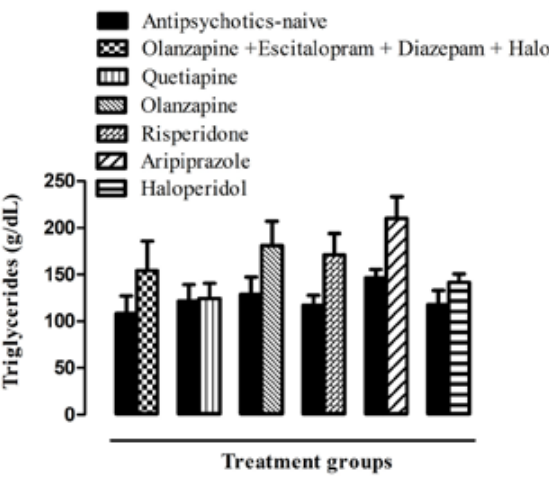
FIGURE 8 - Effect of selected antipsychotics on triglycerides (TGs): Antipsychotic-naïve patients were treated with olanzapine in combination with escitalopram, diazepam (STAT, I.V) and haloperidol (STAT, I.M) (OLEDH, n=8), or quetiapine (QUET, n=8), olanzapine (OLAN, n=8), risperidone (RISP, n=8), aripiprazole (n=8) or haloperidol (n=8) in therapeutic doses for an average time period of 39, 40, 45, 38, 30 and 33 days respectively showing no significant elevation in triglycerides as compared to antipsychotics-naive patients (ANOVA followed by Bonferroni’s Multiple Comparison Test)